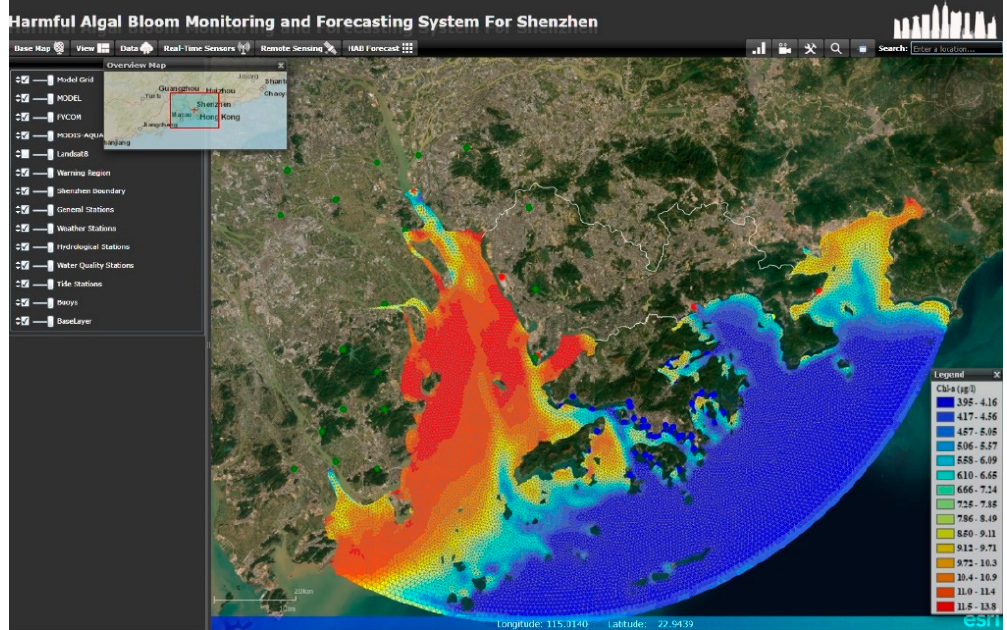
Figure 10. Visualization of assimilated Chl-a on 10 July 2018 over the Shenzhen coastal areas.